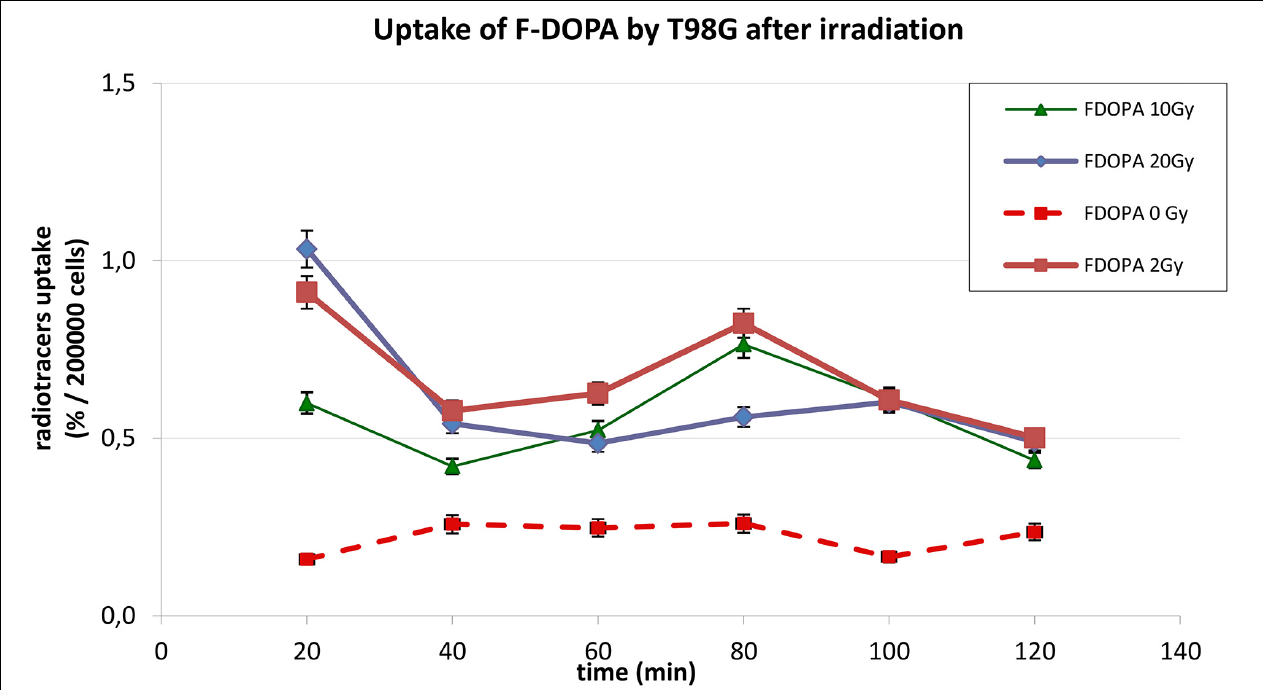
FIGURE 3 | Uptake of 18 F-DOPA in T98G cells in basal condition and after photon irradiation with 2, 10, and 20 Gy.